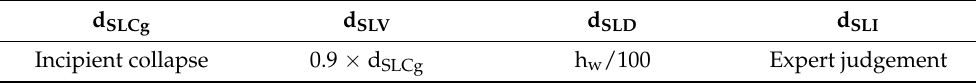
Table 2. Limit states in